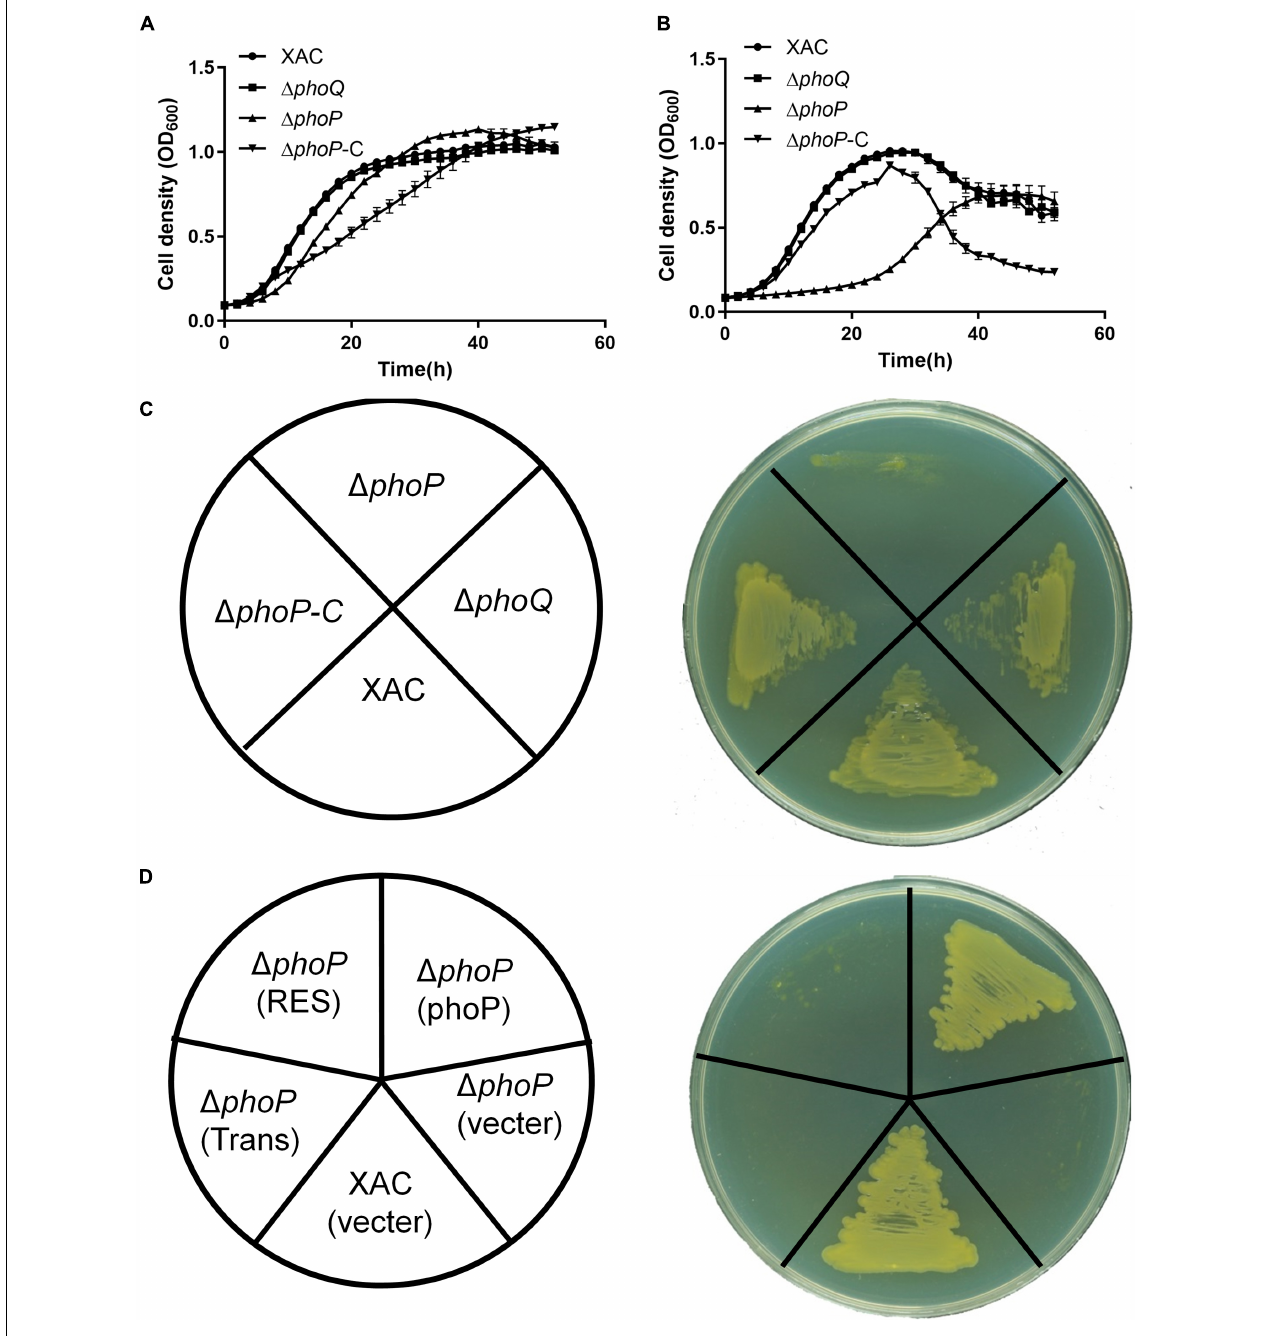
FIGURE 1 | Inactivation of phoP reduces the growth of X. citri strains. (A) Growth curves of bacterial strains in rich YEB medium. (B) Growth curves of bacterial strains in rich NYG medium. (C,D) Growth of bacterial strains on rich NYG medium plates. OD 600 of cultures was monitored using a Bioscreen-C Automated Growth Curves Analysis System (Oy Growth Curves FP-1100-C, Helsinki, Finland). Trans and Res, respectively, represent the Trans_reg_C and response_reg domains of PhoP. Error bars mean ± standard deviation ( n = 3). All experiments were repeated three times with similar results.